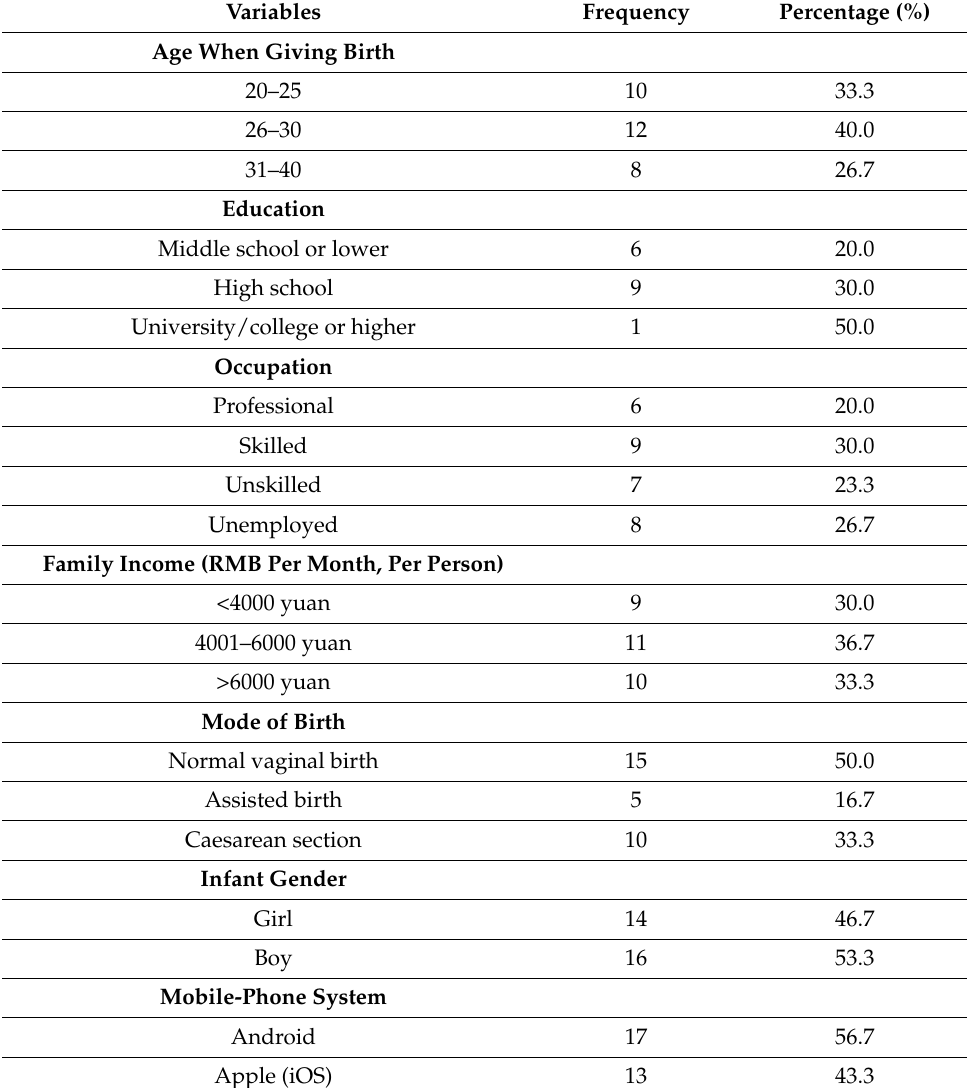
Table 1. Socio-demographic and clinical data of participants ( n =